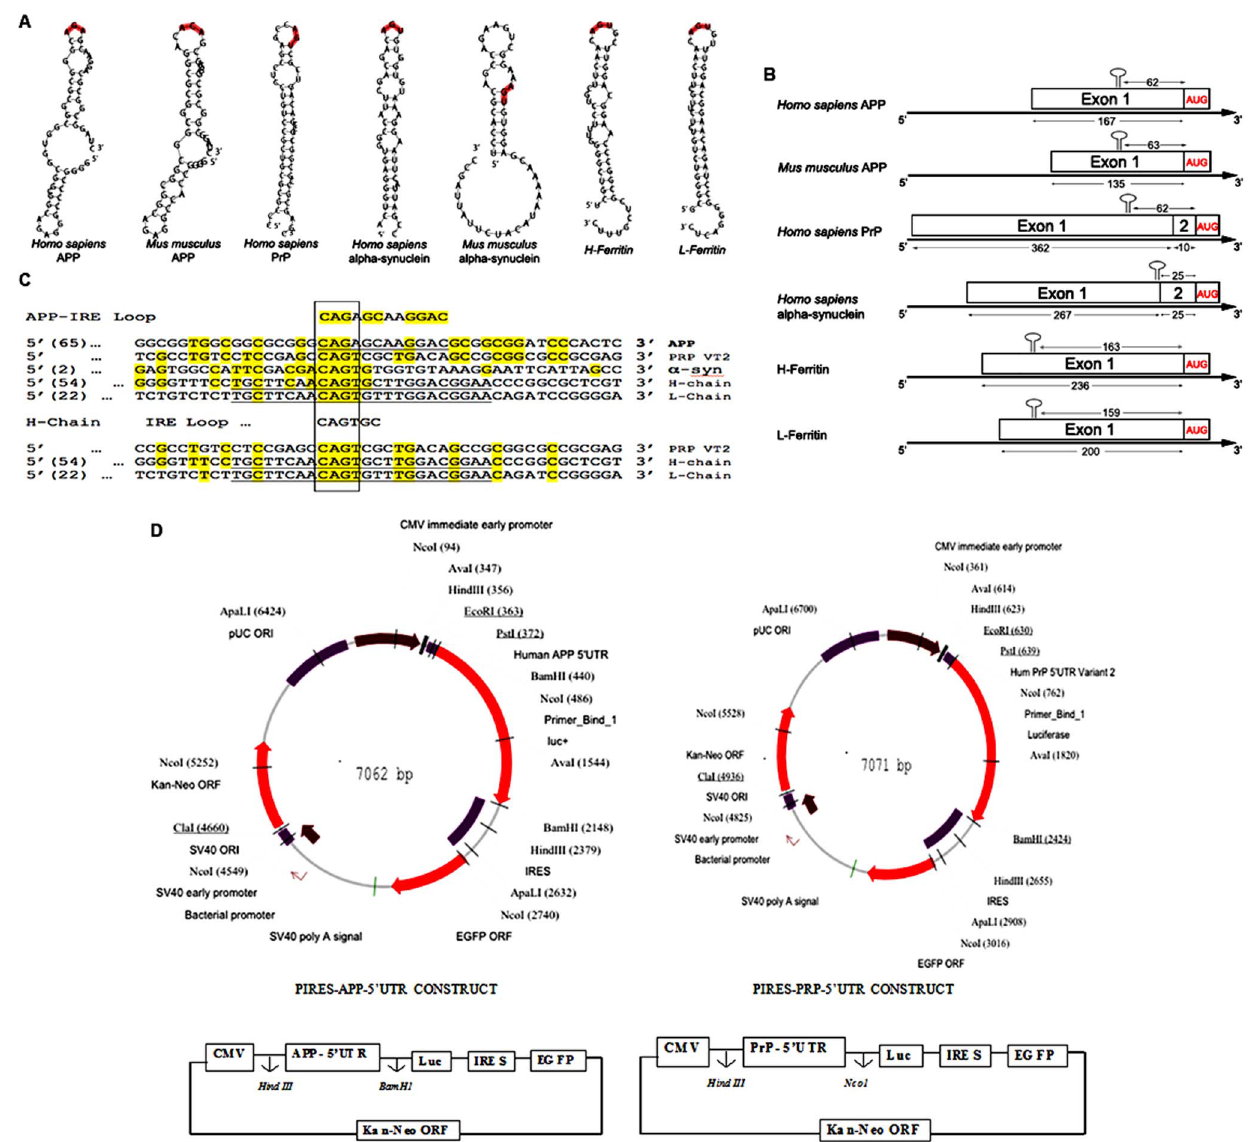
Figure 1. Alignment of human and mouse APP 5 9 UTRs with human PrP 5 9 UTR sequences relative to the L- and H-ferritin Iron- responsive elements (IREs). Panel A : The human and mouse APP 5 9 UTR specific IRE-like RNA stem loops, the human PrP 5 9 UTR, and the human and mouse SNCA specific IRE –like stem loops each aligned adjacent to the ferritin L- and H IRE RNA stem loops. Shown, the L- and H-mRNAs encode canonical IRE RNA stem loops whereas the APP IRE in non canonical although fully iron responsive [6]. The a -synuclein IRE ( SNCA IRE) represents a non canonical IRE traversing the central splice junction of exon-1 and exon-2 (the CAGUGN loop/splice site sequences) of SNCA mRNA [49]. Typical IRE stem loops fold to exhibit an apical AGU pseudotriloop which is depicted in red lettering at the apex of the H-ferritin and SNCA IREs [28] relative to an analogous AGA from the IRE–like stem loop encoded by APP mRNA [6]. Panel B : Maps of the 5 9 UTRs encoding by the human and mouse APP mRNAs, PrP mRNA, SNCA mRNA, and the mRNAs for L- and H-ferritin (IRE stem loops are displayed as lollipops). Panel C : Relative alignment of the sequences that encode the 5 9 UTR specific IRE-like stem loops in human APP mRNA, PrP mRNA, SNCA mRNA, and the L- and H-ferritin mRNAs. Panel D : Screen and counter-screening Constructs [ 21 ] : The human APP 5 9 UTR cassette was subcloned in front of the luciferase reporter gene in the dicistronic pCD(APP) reporter construct. The same-sized and related PrP 5 9 UTR was subcloned in an identical format into the pCD(PrP) reporter construct for the purpose of counter-screening, as described in the materials and methods